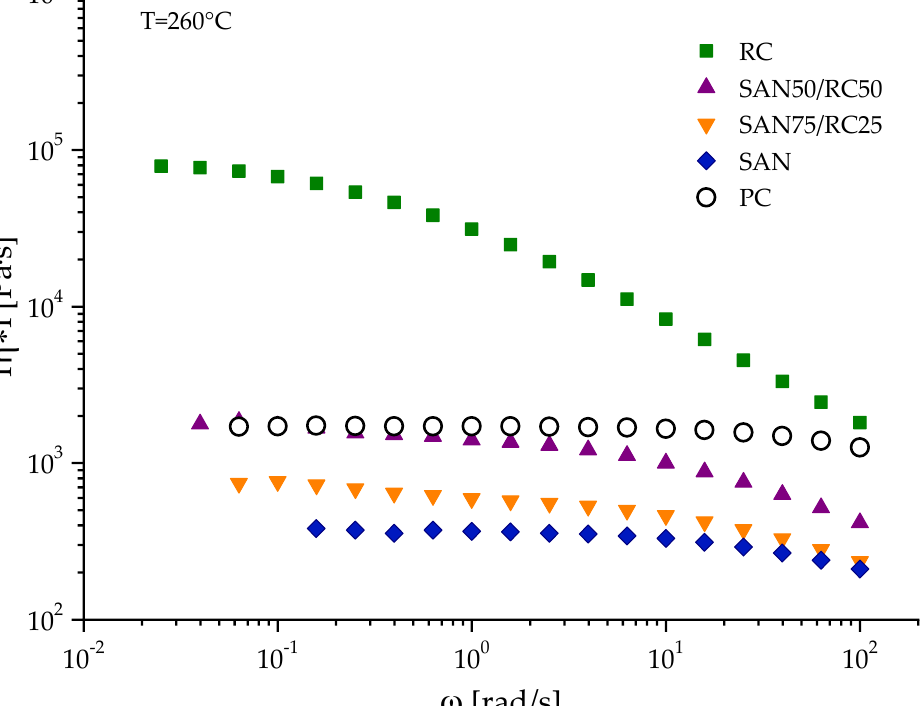
Figure 7. Complex melt viscosity | η *| in dependence of oscillation frequency at 260 ◦ C for the different blend components.